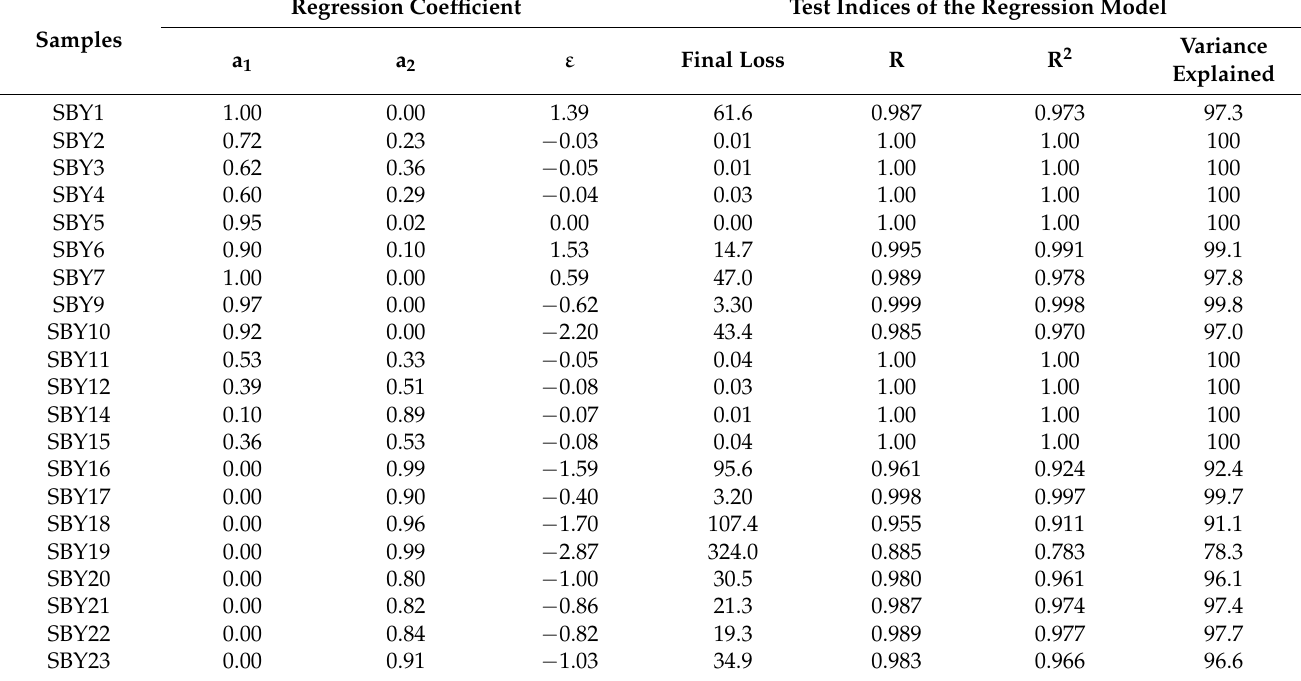
Table 1. Quantitative provenance analysis results for the very fine sand fraction of the sediments in the Subei littoral plain area (a 1 is the contribution percentage of the Yangtze River, a 2 is the contribution percentage of the ancient Yellow River, ε is the contribution other unknown